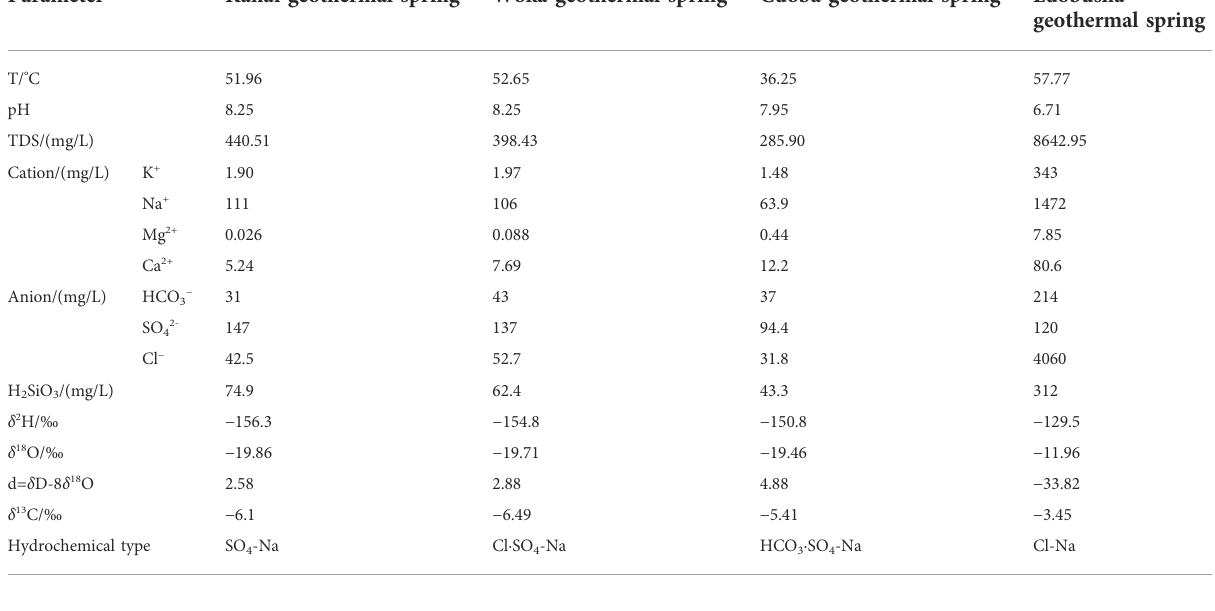
TABLE 2 Hydrochemical and D-O-C isotopic results of geothermal springs.